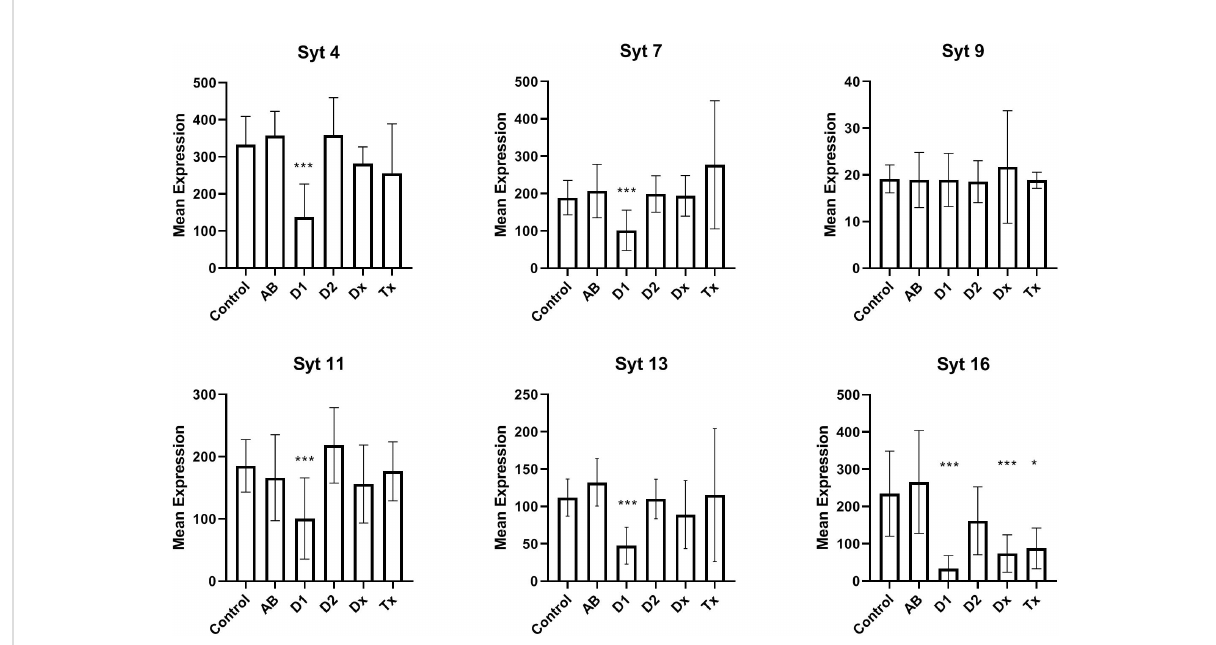
FIGURE 2 Expression levels of selected synaptotagmins in human islet of Langerhans. See Figure 1 for patient groups and additional information. *p<0.05, **p<0.01,